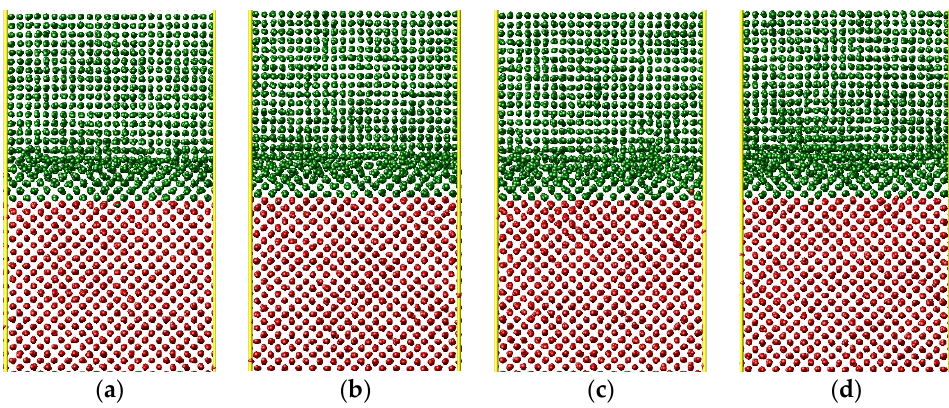
Figure 11. The calculated results of the model with BCC α Fe and FCC Cu: ( a ) 750 °C; ( b ) 800 °C; ( c ) 850 °C; ( d ) 900 °C.